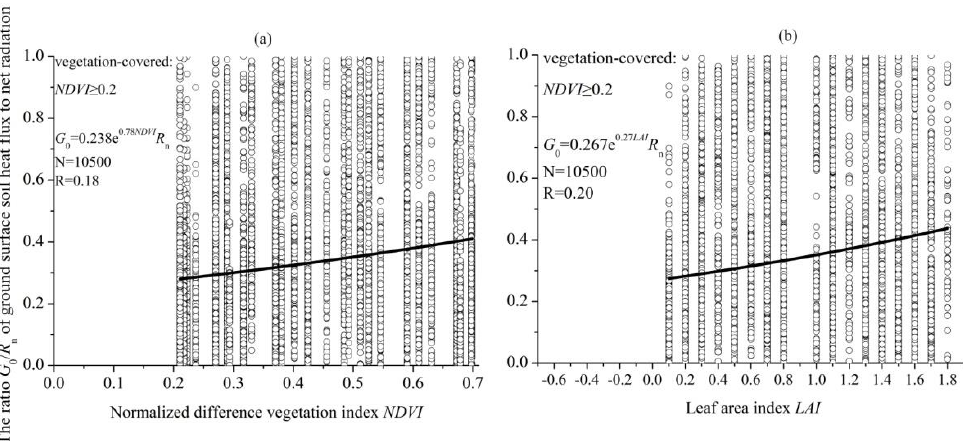
Figure A1. Adjustment scatter plot for the adjusted schemes Clawson adj ( a ) and Choudhury adj ( b ). ( R , the correlation coefficient; N, the number of samples.).